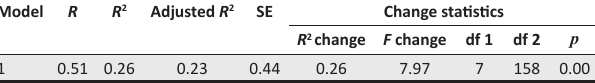
TABLE 9: Regression model summary for joint effect of independent